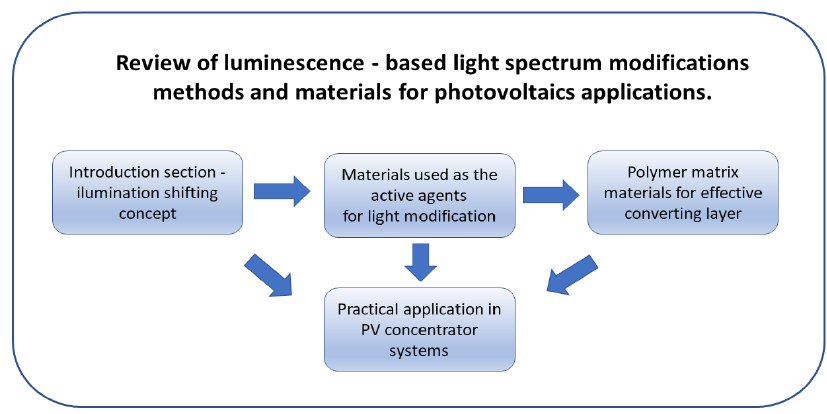
Figure 3. Schematic of the presented article scope and flow .